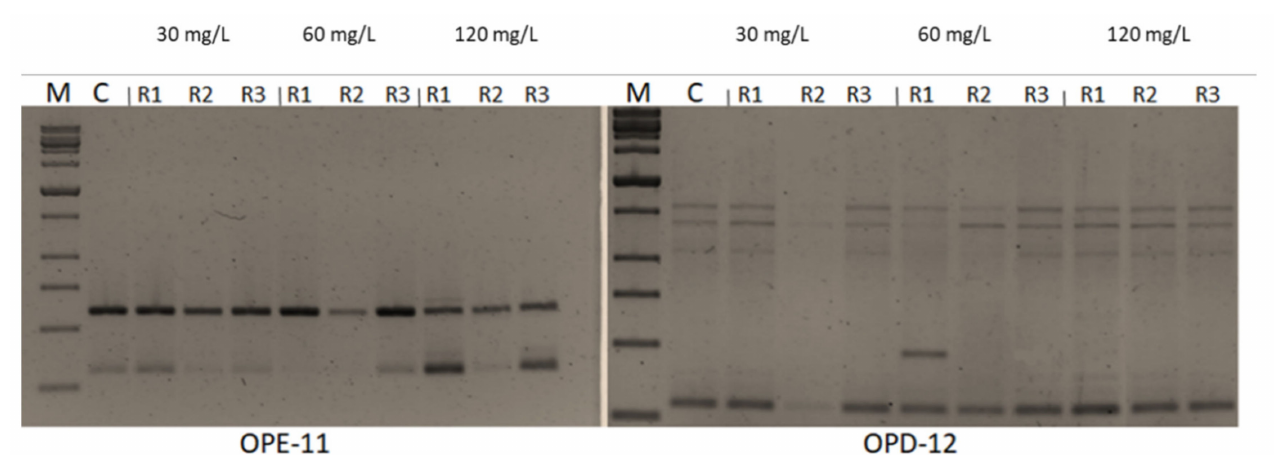
Figure 5. RAPD profiles of banana plants treated with 30, 60 and 120 mg L − 1 CuSO 4 5H 2 O using primers OPE-11 and OPD-12. M: Molecular weight marker (1000bpSizer DNA ladder), C: Control plant. Control = 0.025 mg L − 1 and represents the concentration of CuSO 4 5H 2 O in MS medium (without copper sulphate